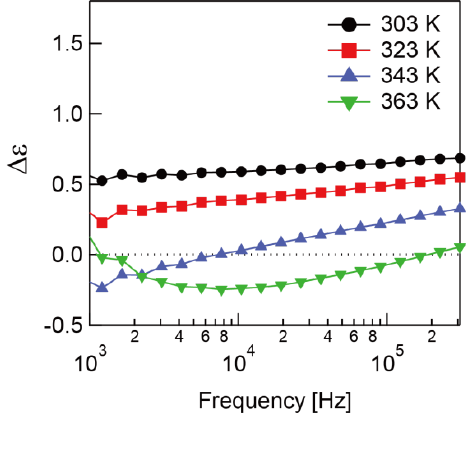
Figure 8 . Frequency dependence of the dielectric anisotropy after